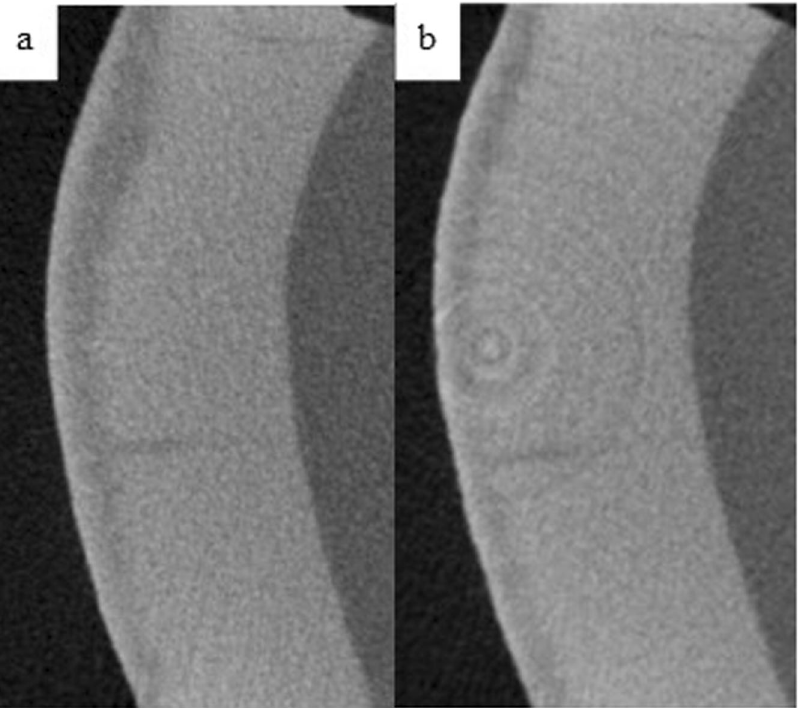
Fig. 5 Remineralization of unetched enamel MIH lesions with 1450 ppm NaF toothpaste. Representative µ-CT images of unetched enamel MIH lesions, before ( a ) and after ( b ) in-situ